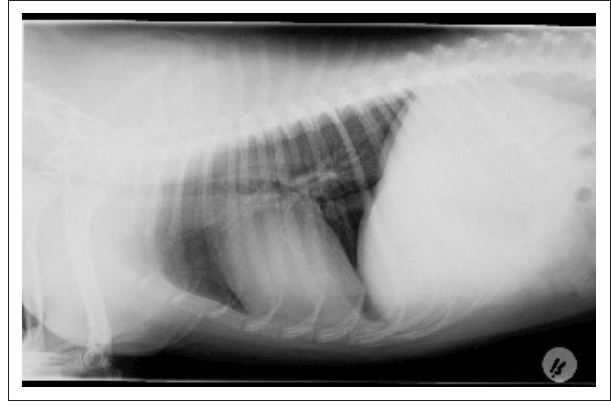
FIGURE 3: Right lateral thoracic view – no signs of a caudal thoracic mass or spondylitis present.